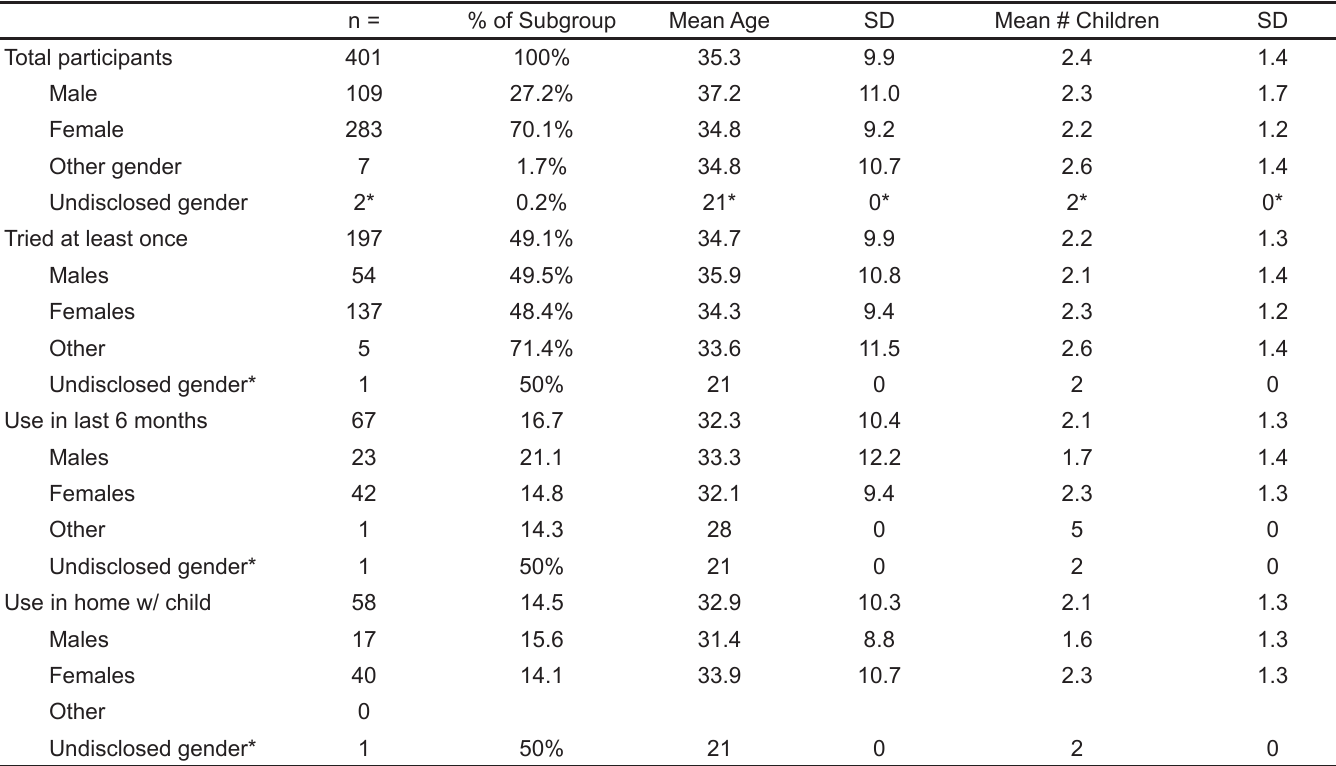
Table 1. Participant demographics and history of cannabis use.